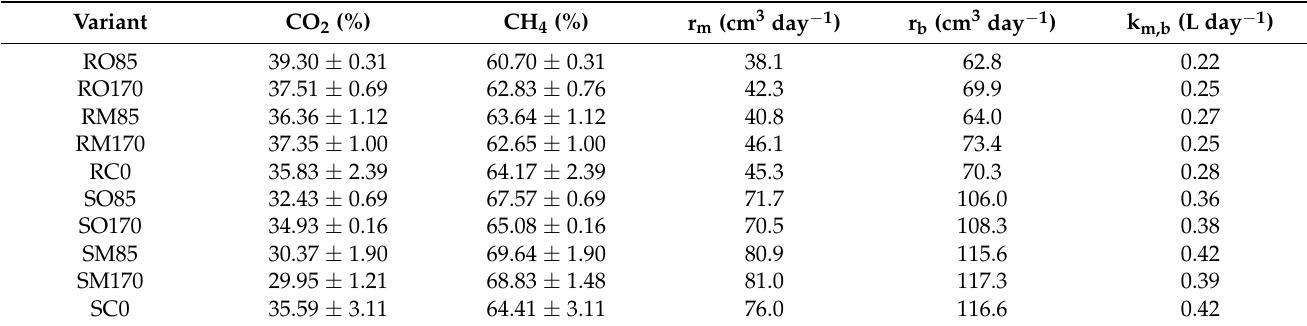
Table 5. Carbon dioxide (CO 2 ) and methane (CH 4 ) content in biogas, methane (r m ), and biogas (r b ) production rate and reaction rate constant (k m,b ) of the analyzed silage, and raw material of Helianthus salicifolius